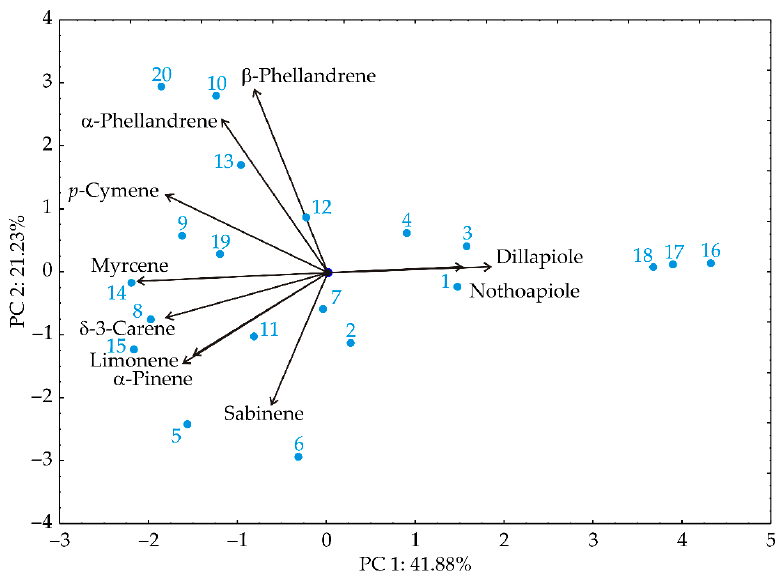
Figure 2. The PCA biplot diagram describing the relations between A. archangelica root volatile compounds. The unrooted cluster tree (Figure 3) constructed according to A. archangelica root vol-